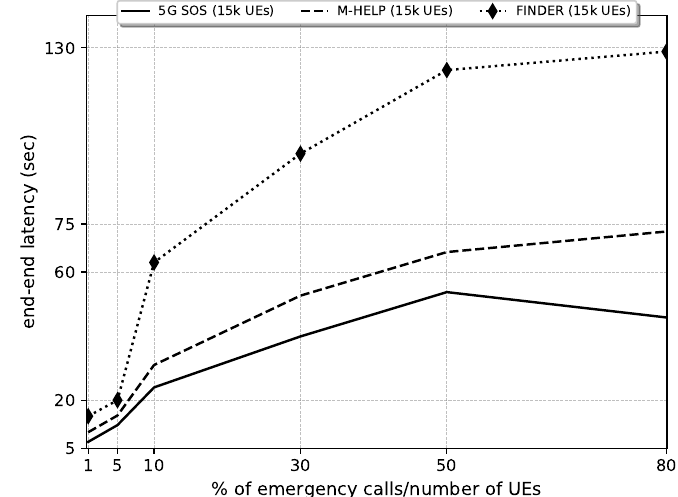
Figure 15. Comparison of end–end latency against the ratio of the number of emergency calls (NEC) to the number of UEs (NoU) under 5G-SOS, M-HELP, and FINDER. Parameters: NEC: 1% of NoU to 80% of NoU, NoU: 15,000 UEs, ETI: 1800 s (30 min).